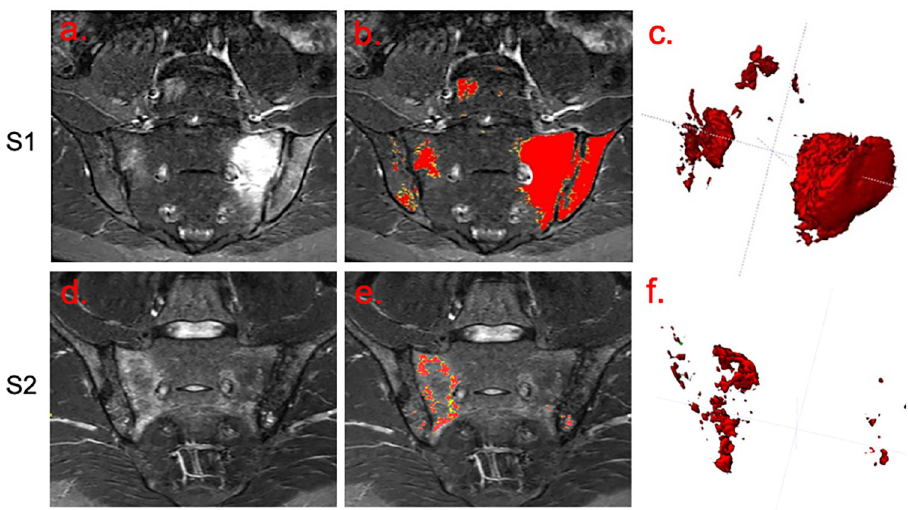
Fig 3. Example outputs from human-machine workflow. Scans for two subjects are shown (S1 and S2, top and bottom row respectively). The left-hand column shows the STIR images, the middle column shows the preliminary segmentations (not cleaned to provide a demonstration of the performance of the automated component) and the right column shows visual summaries of the disease volume. Note that inflammation at the periphery of segmented lesions is typically captured by the lower ‘sensitive’ threshold, shown in yellow, whereas the most hyperintense inflammation in the centre of lesions is captured by the higher, ‘conservative’, threshold, shown in